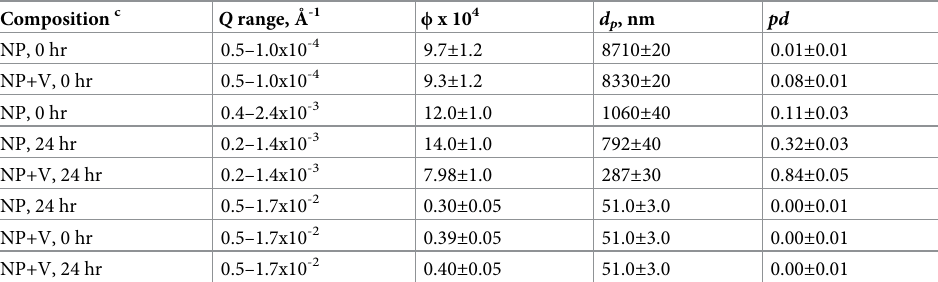
Table 1. Results from model fitting of SANS+USANS “excess” data plotted in Fig 3 a,b . Composition c Q range, Å -1